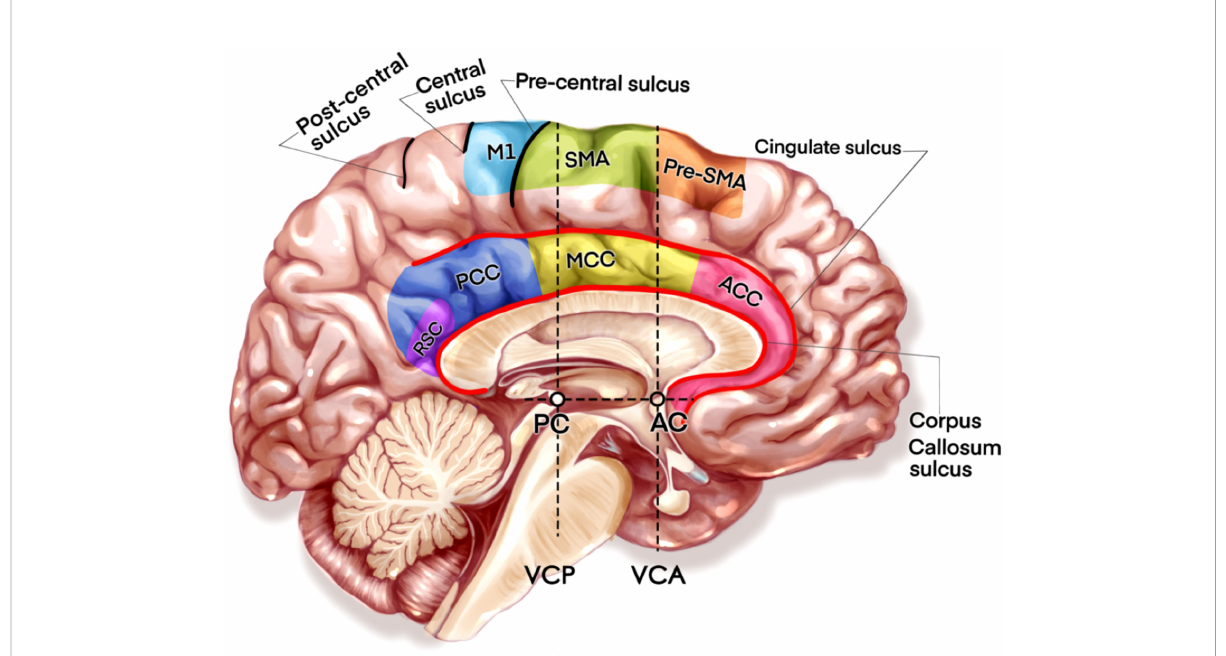
FIGURE 1 The illustration of four cingulate subregions and nearby motor related areas. AC, Anterior Commissure; PC, Posterior Commissure; VCA, Vertical Plane at the AC; VCP, VCA: Vertical Plane at the